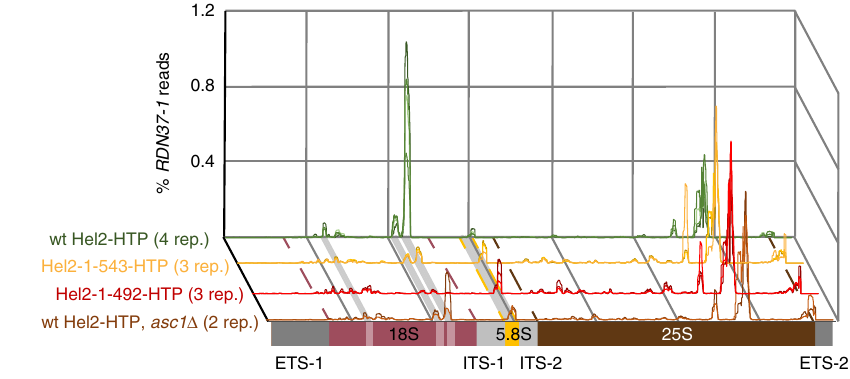
Fig. 5 Effect of ASC1 deletion on Hel2 18S binding and comparison to truncation mutants. As Fig.